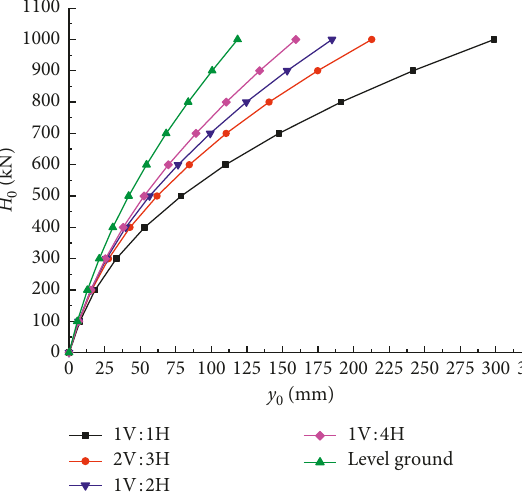
Figure 5: Pileheadload-displacementcurves fordifferent sloperatios.